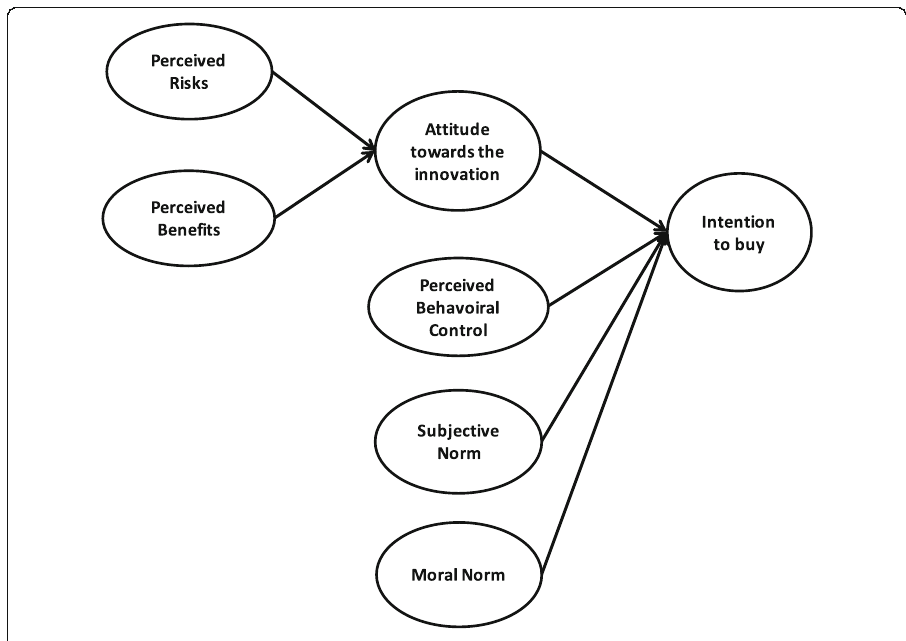
Fig. 1 Consumer innovation acceptance model used in this